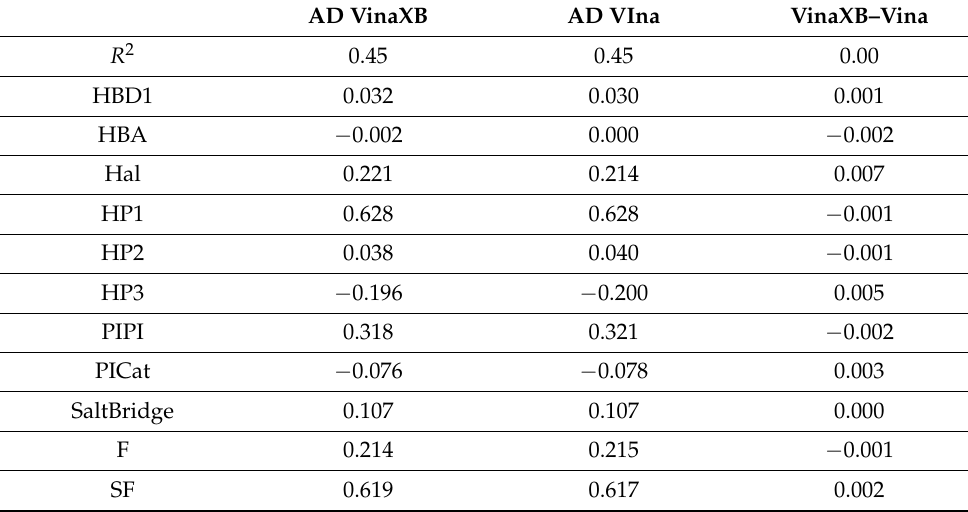
Table 8. Regression coefficients for combined models (FW + AD Vina and FW + AD